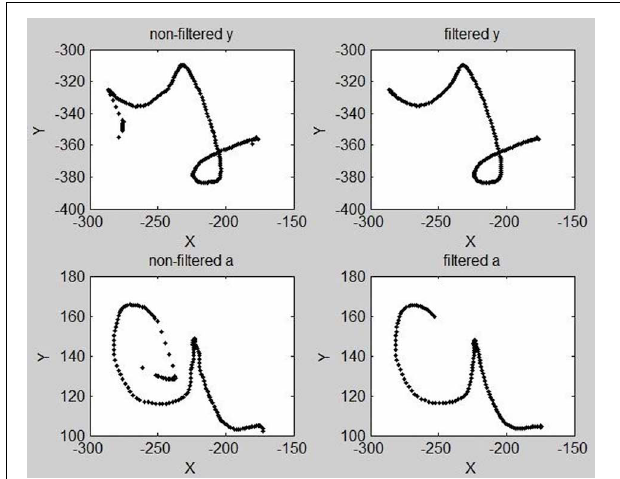
FIGURE 4 | Illustration of the filtering and trimming of trajectories. Left: Raw trajectory for a “y” exemplar (blue dots), and the resulting filtered and trimmed trajectory (red dots). Right : acceleration profile of the raw trajectory. Spurious saccades in movement initiation correspond to easily detected and filtered